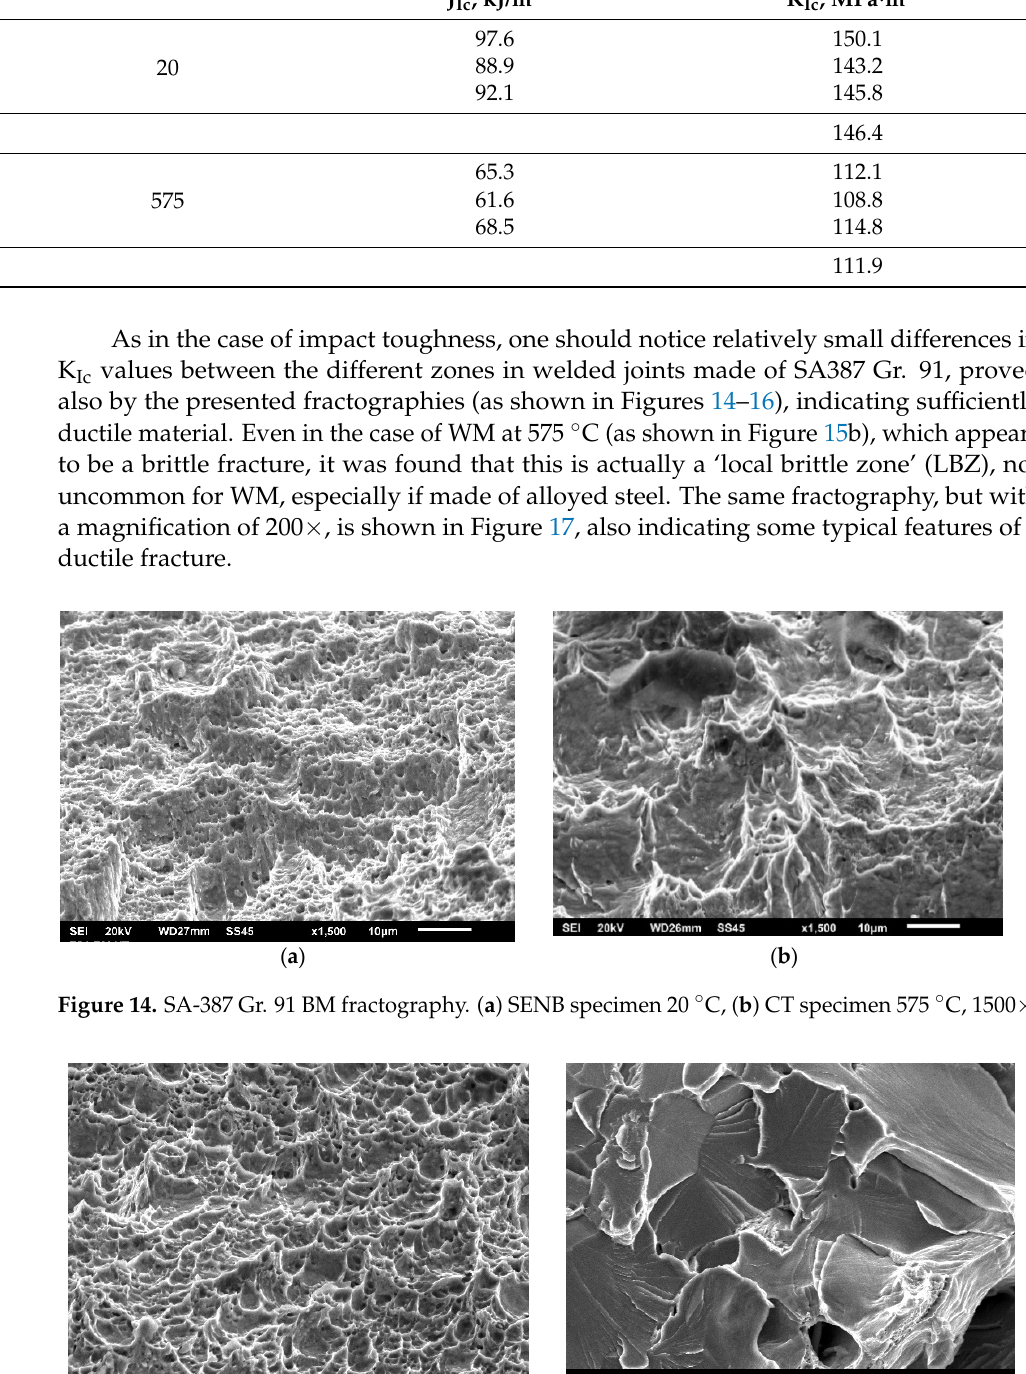
( b ) Figure 16. SA ‐ 387 Gr. 91 BM fractography. ( a ) SENB specimen 20 ° C, ( b ) CT specimen 575 °C, 1,500×. Figure 17. SA ‐ 387 Gr. 91 WM fractography, CT specimen 575 °C, 200×. Values for K Ic in the case of A387 Gr. B steel are provided for comparison in Tables 13–15 for BM, WM, and HAZ, respectively. In this case, the results for fracture toughness are different from those for impact toughness in two important aspects: the first is that 1% Cr steel has lower values than 9% Cr, and the second is that WM is now the region with the highest crack resistance, whereas HAZ is the weakest link. However, the differences are very small, since the average values for WM are circa 10% higher, and for HAZ circa 10% lower, than BM average values. Therefore, the effect of heterogeneity is less pro ‐ nounced than in the case of SA 387 Gr. 91 steel, whereas the effect of temperature is slightly stronger (the ratio between 20 °C and 575 °C values is circa 1.4, which is almost the same as in the case of SA 387 Gr. 91).